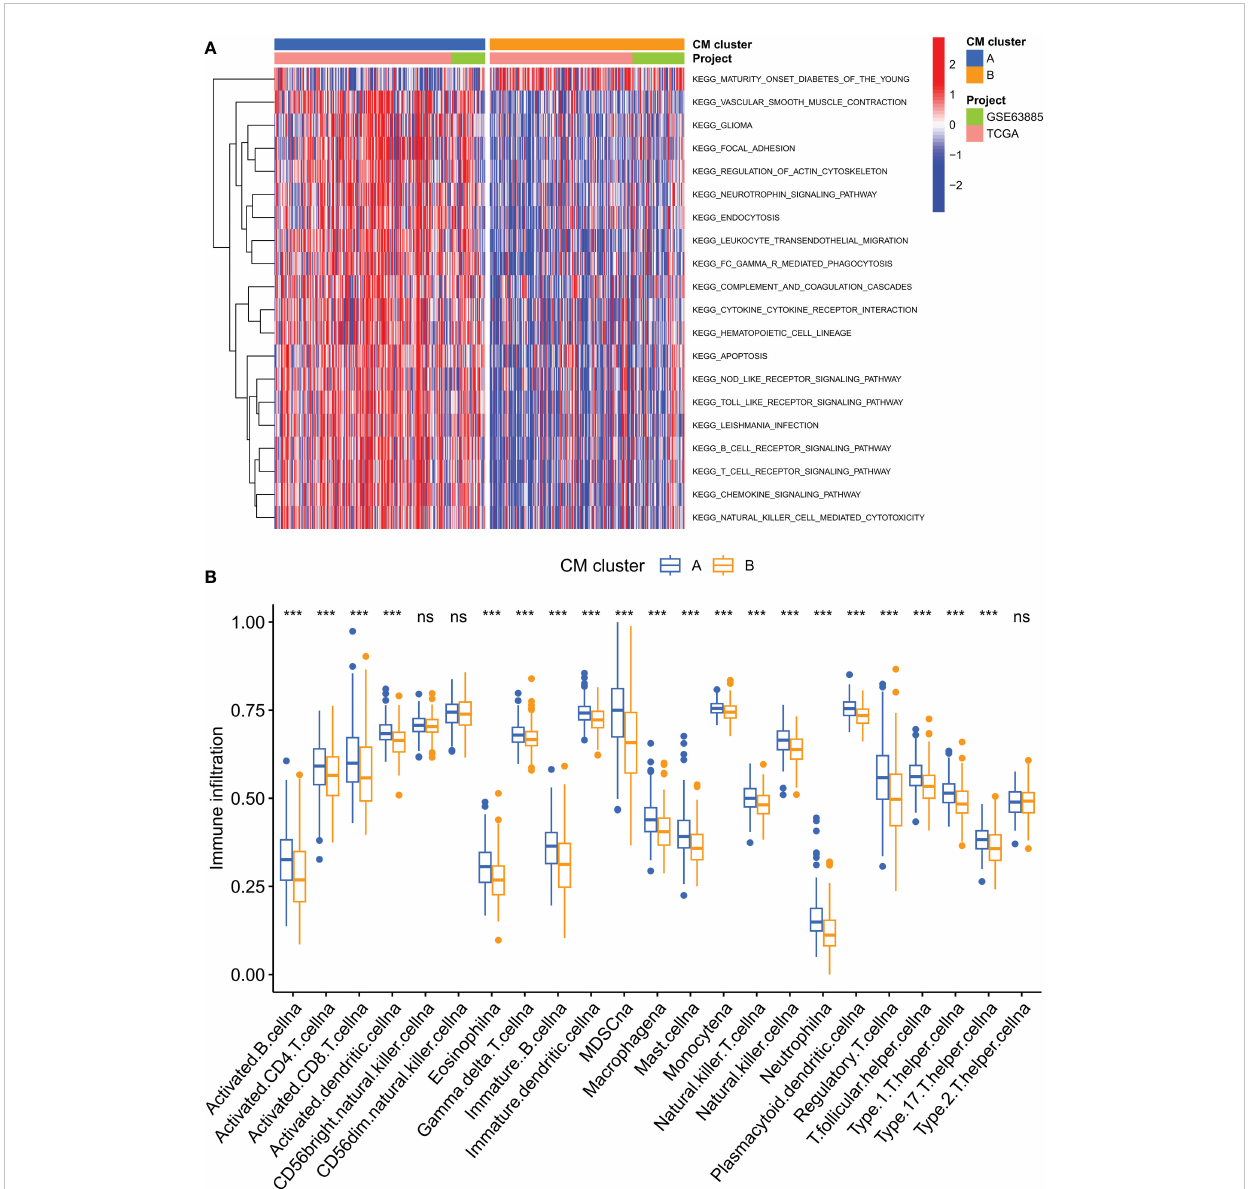
FIGURE 3 Analysis of the immune microenvironment of two CM clusters of tumors. (A) The abundance of 23 in fi ltrating immune cell species in two CM clusters. (B) GSVA of biological pathways between two clusters. ***p < 0.001; ns, no signi fi